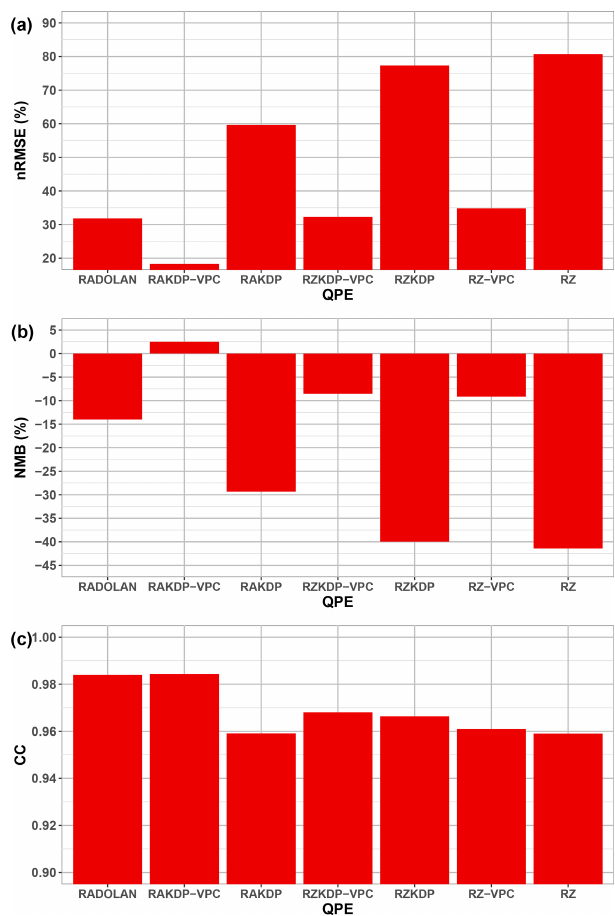
Figure 3. Point-scale evaluation scores of radar-based QPEs with respect to measurements from 63 rain gauges (Fig. 2) of total pre- cipitation depth of 14 July